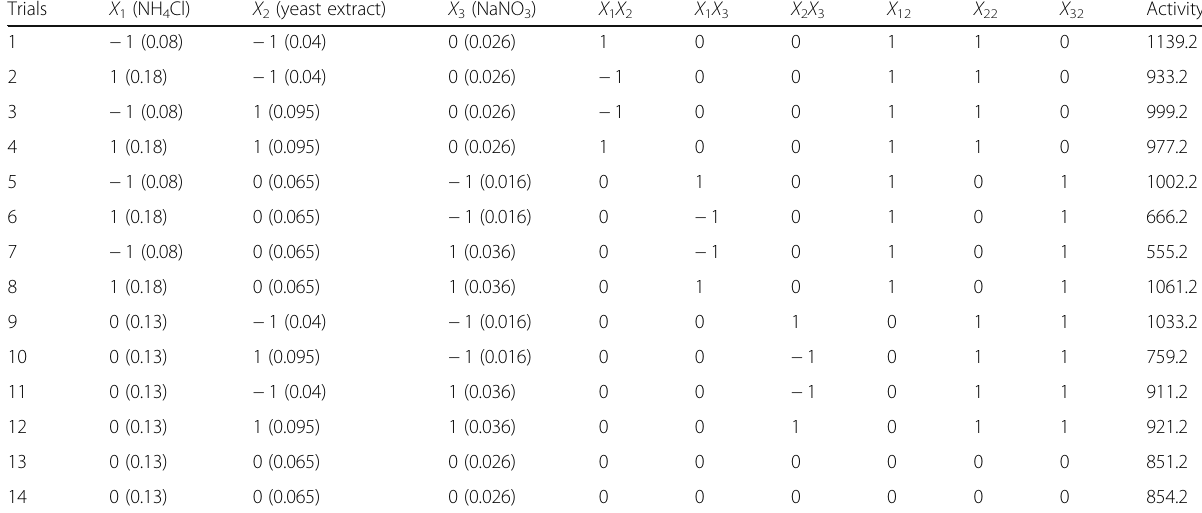
Table 3 Matrix designed, studied variables, and levels for Laceyella sacchari strain (YNDH) BB factorial experimental design Trials X 1 (NH 4